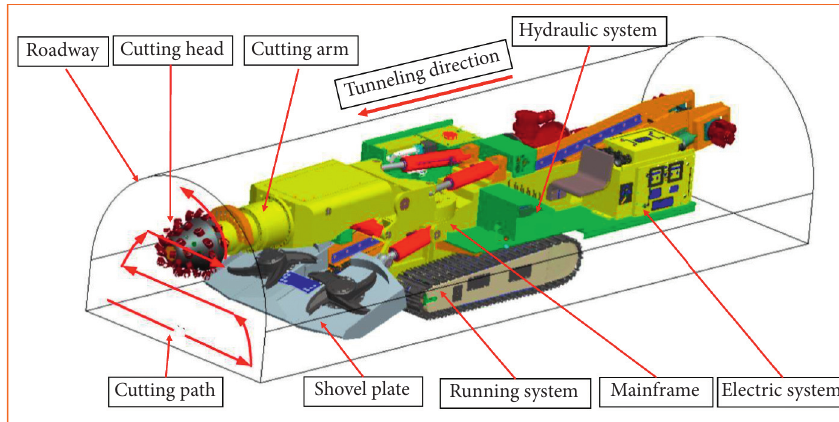
Figure 2: Operation diagram of the roadheader.